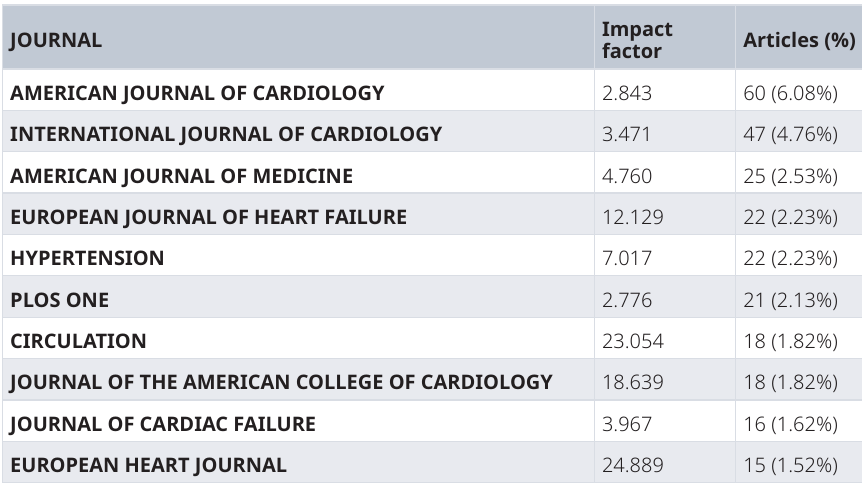
three affiliations in terms of publications using BioLINCC data were University of Alabama at Birmingham, Univer- sity of California system, and Harvard University as shown